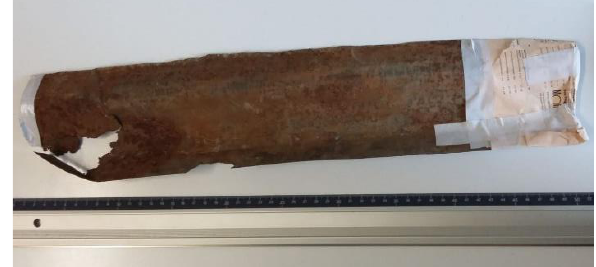
Figure 3: 11 Corrugated Metal, rusty condition.